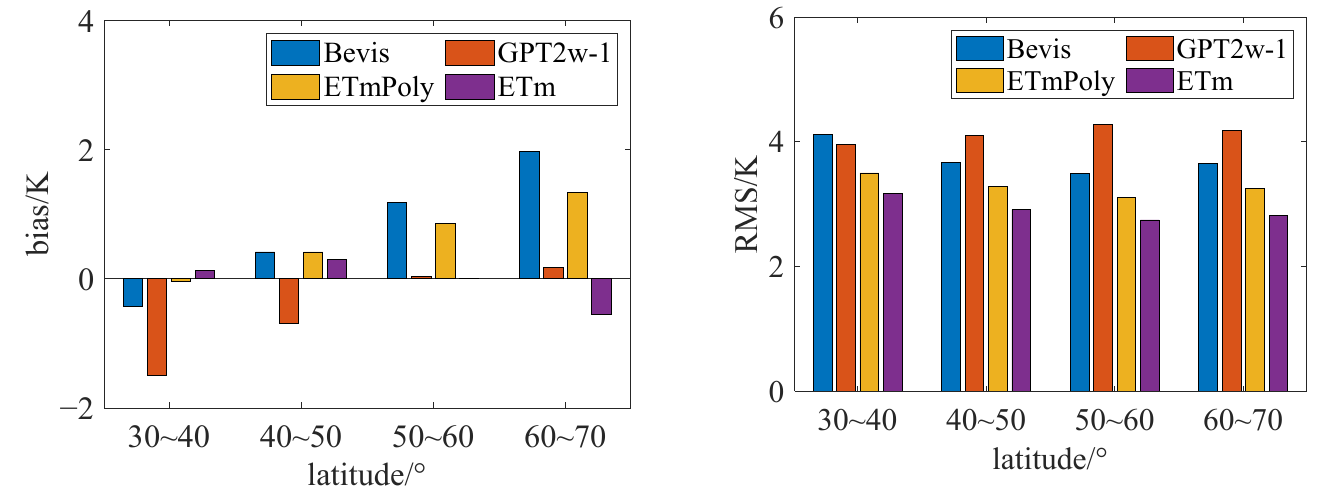
Figure 7. Results of the bias and RMS of the four Tm models at different latitude ranges.